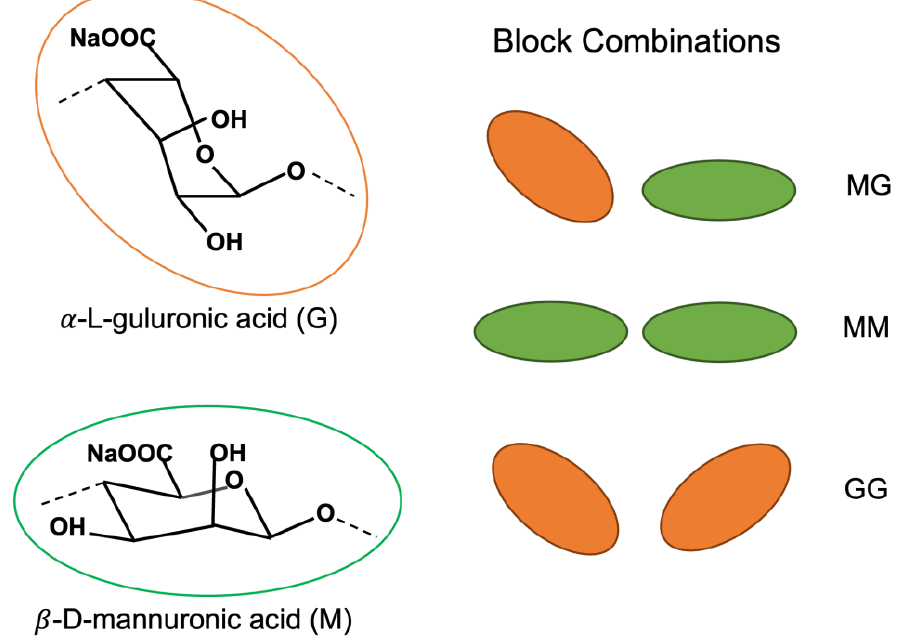
Figure 1. Schematic of uronic acids their arrangements in homo- and heteropolymeric blocks.